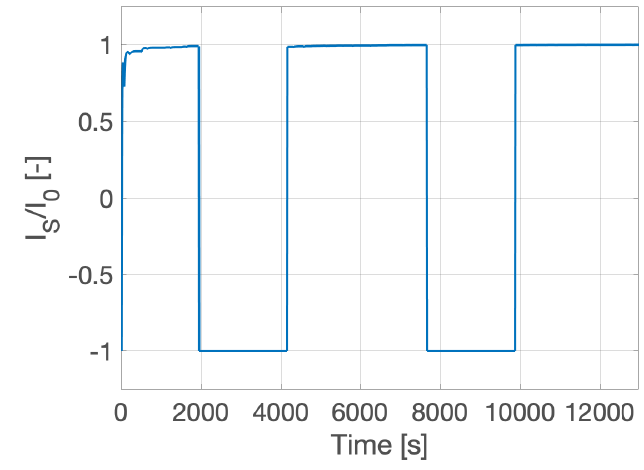
Figure 5. Specific solar arrays current, with eclipses.